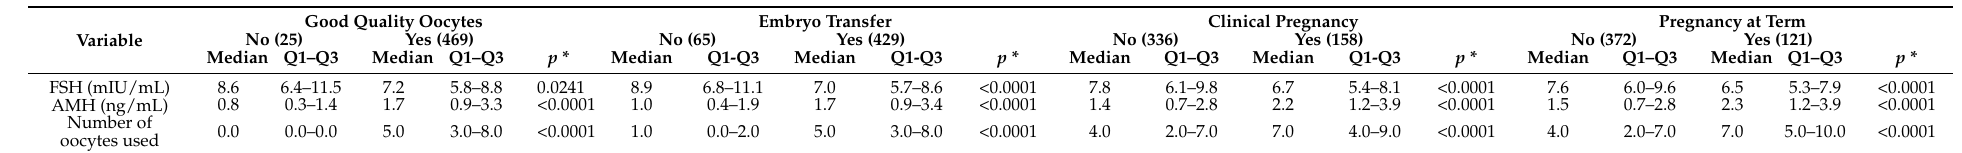
Table 4. Concentrations of Anti-Müllerian hormone (AMH) and follicle-stimulating hormone (FSH) and number of oocytes used for retrieval according to IVF